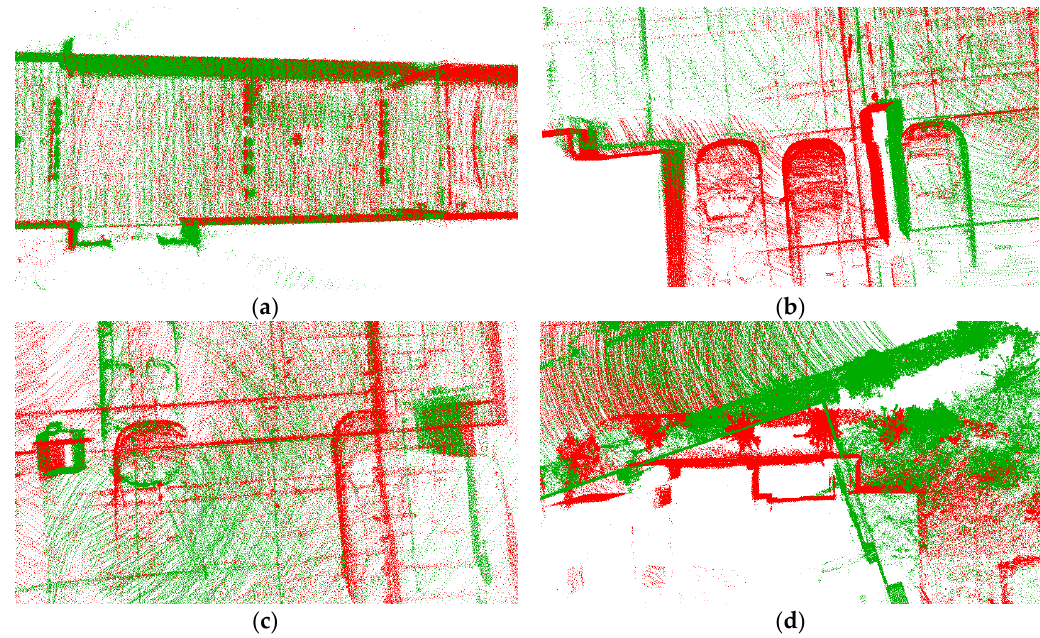
Figure 17. Examples of registration results corresponding to error edges in the pose graph. ( a ) Registration result corresponds to edge 1 in Figure 16; ( b ) registration result corresponds to edge 2 in Figure 16; ( c ) registration result corresponds to edge 3 in Figure 16; ( d ) registration result corresponds to edge 4 in Figure 16.